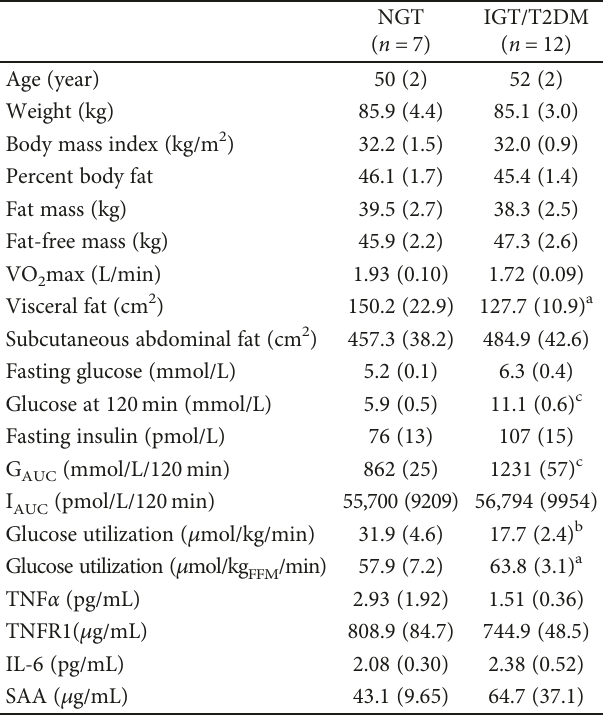
Table 1: Baseline body composition, glucose metabolism, and in fl